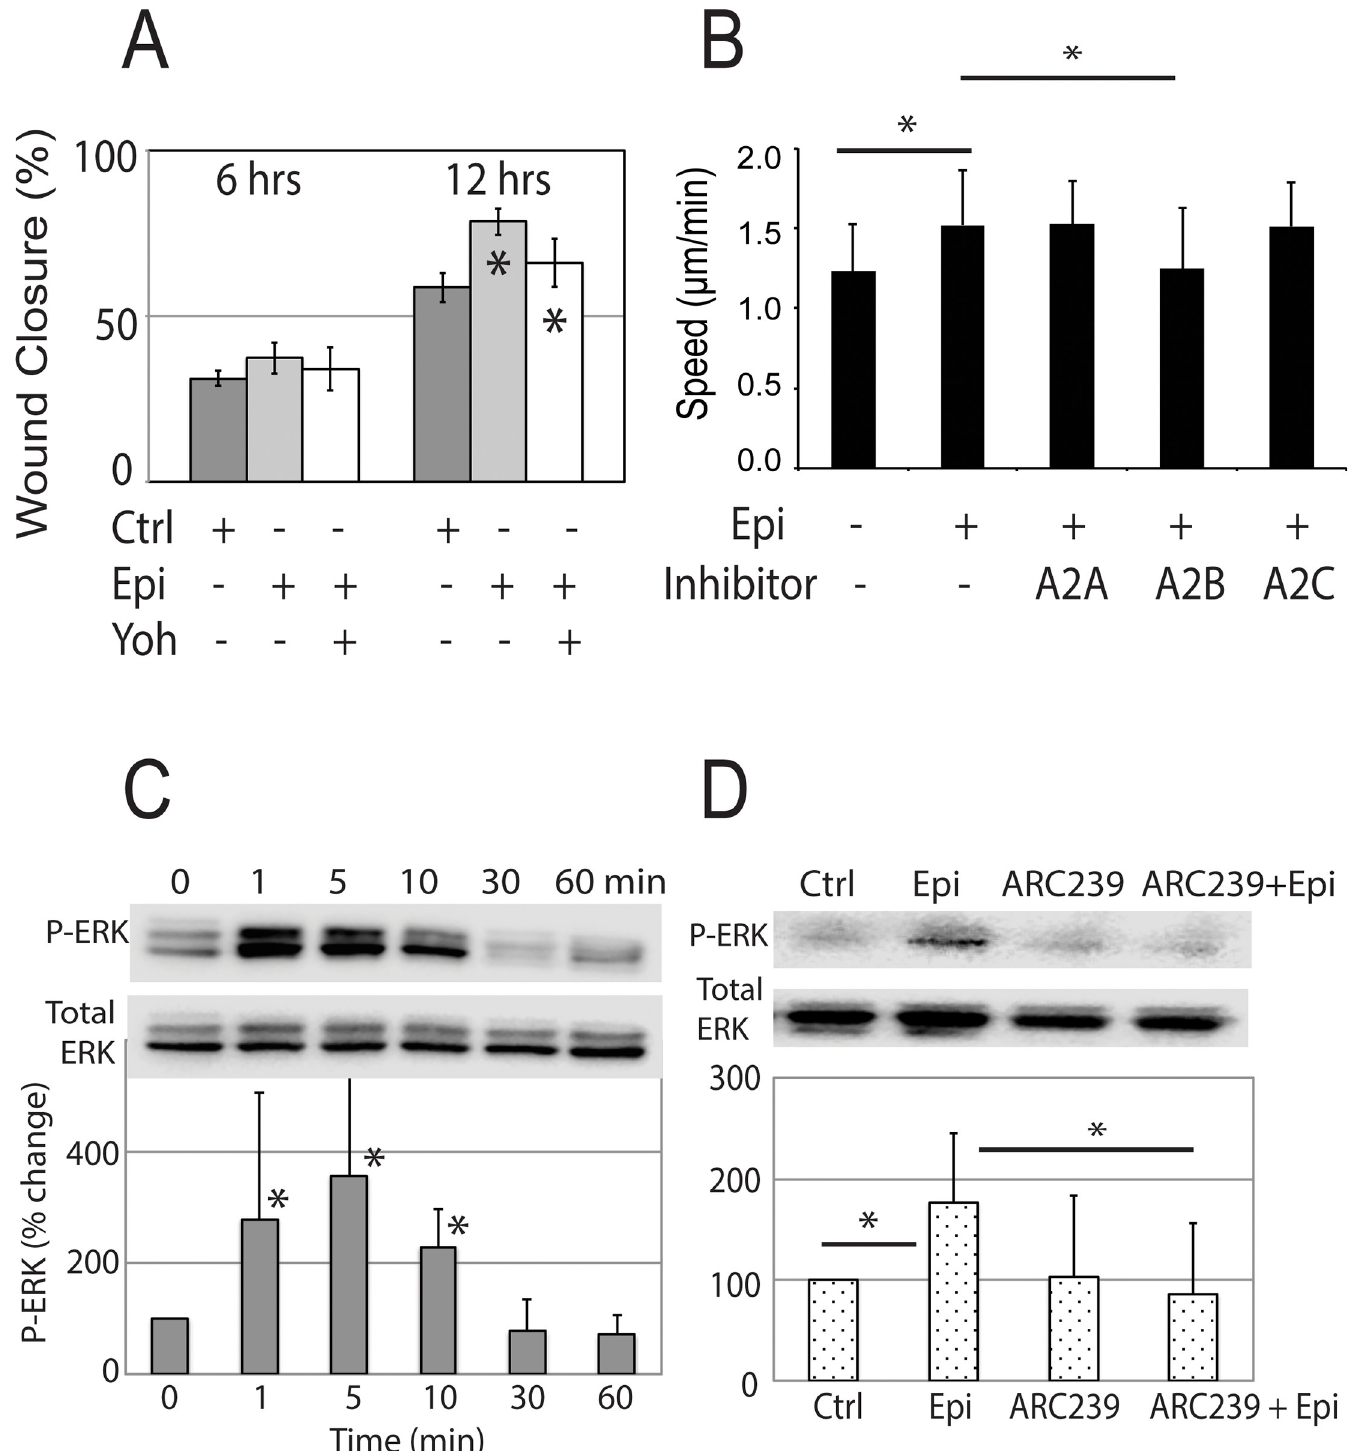
Fig 2. Inhibiting alpha-AR reversed the fast migration and ERK phosphorylation induced by low level of epinephrine. Epinephrine-induced, fast keratinocyte migration could be reversed by co-treatment with an alpha-AR inhibitor (A) 10 μ M yohimbine (Epi + Yoh) or (B) 10 μ M specific inhibitors to the A2B-AR. In (B), the individual speeds of 100–150 cells were tracked in each group in the cell migration assay. (C) Phosphorylation of ERK was increased in keratinocyte lysates at different time points after the 0.1 nM epinephrine treatment. (D) When the A2B-AR specific inhibitor was added to the epinephrine treatment, the increased P-ERK signal was abolished. (N = 3 keratinocyte strains, mean +/- SD, � p < 0.05).